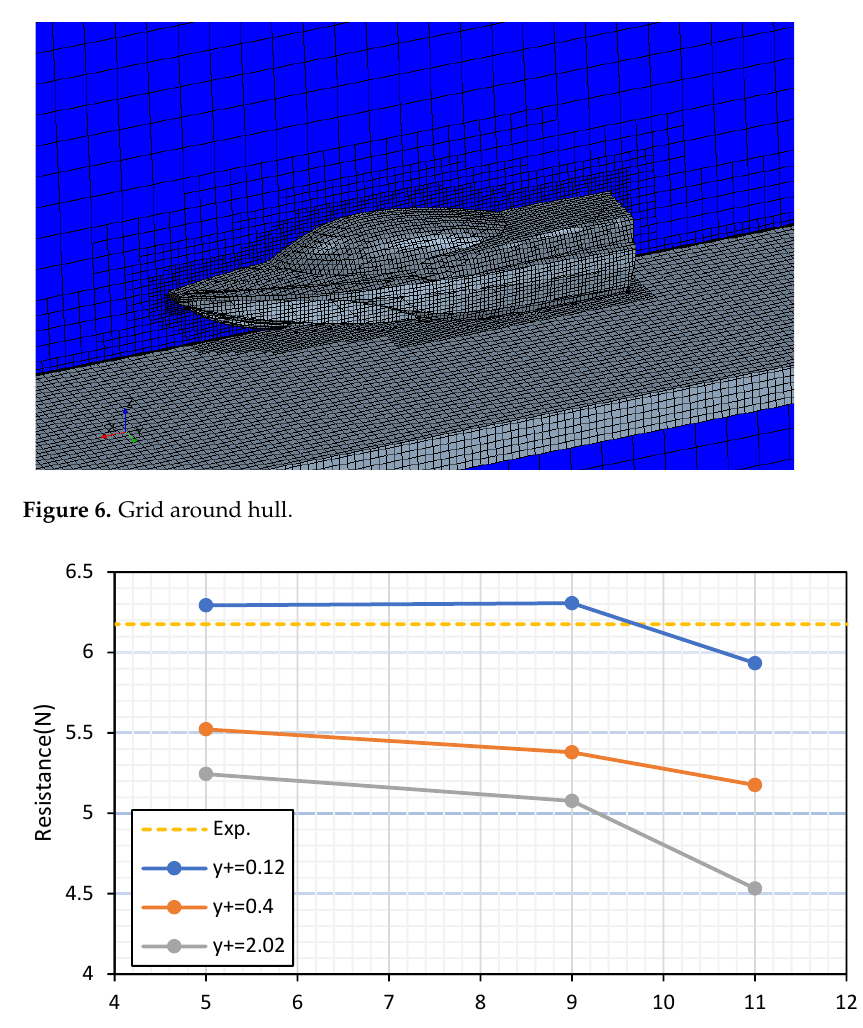
Table 3. Comparison of experimental data and simulation data